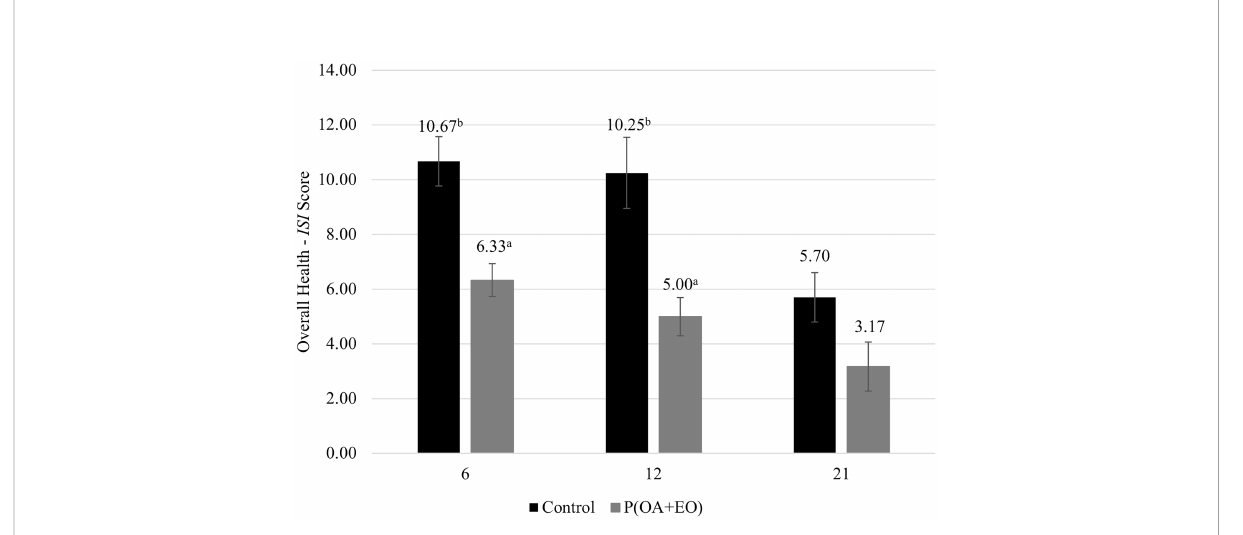
FIGURE 1 Overall health analyzed by the ISI methodology (sum of the scores given for intestine, liver, proventriculus, annex glands, locomotor, and respiratory system). Data are the mean value and standard error of each treatment at different ages (weeks). ab